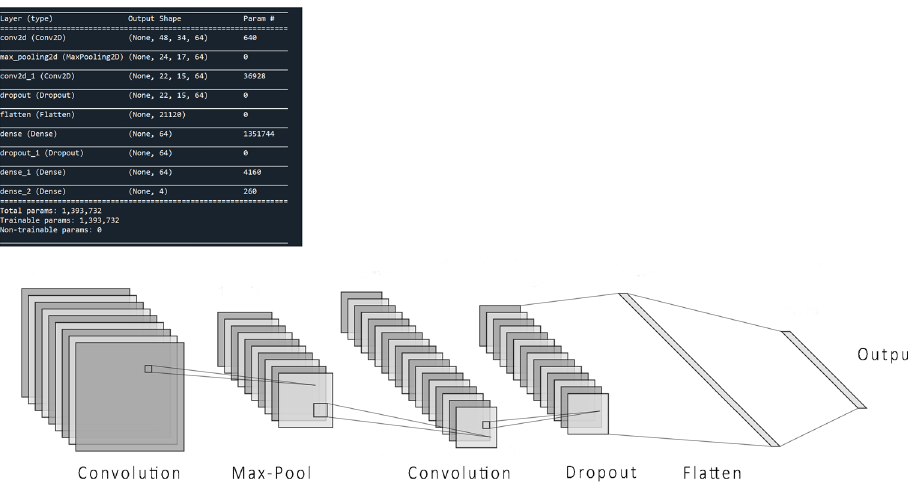
Figure 3. The proposed CNN model with input, convolution, max pool, dense, and output layers. Model summary includes details about hyperparameters and network